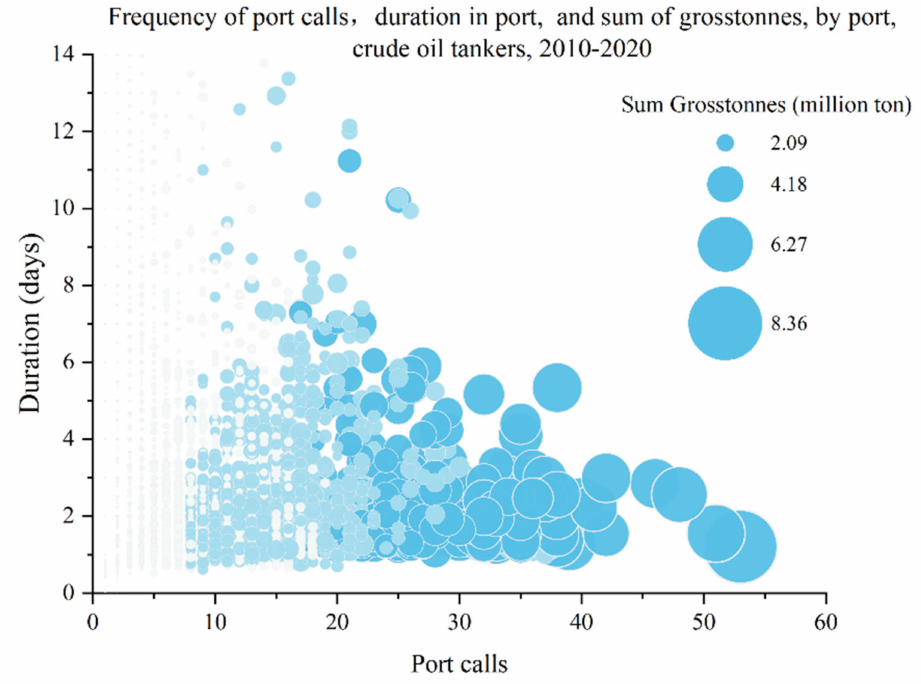
Figure 2. The frequency of port-calls, the average time of docking on ports and the sum of total gross tonnage of the tankers, in